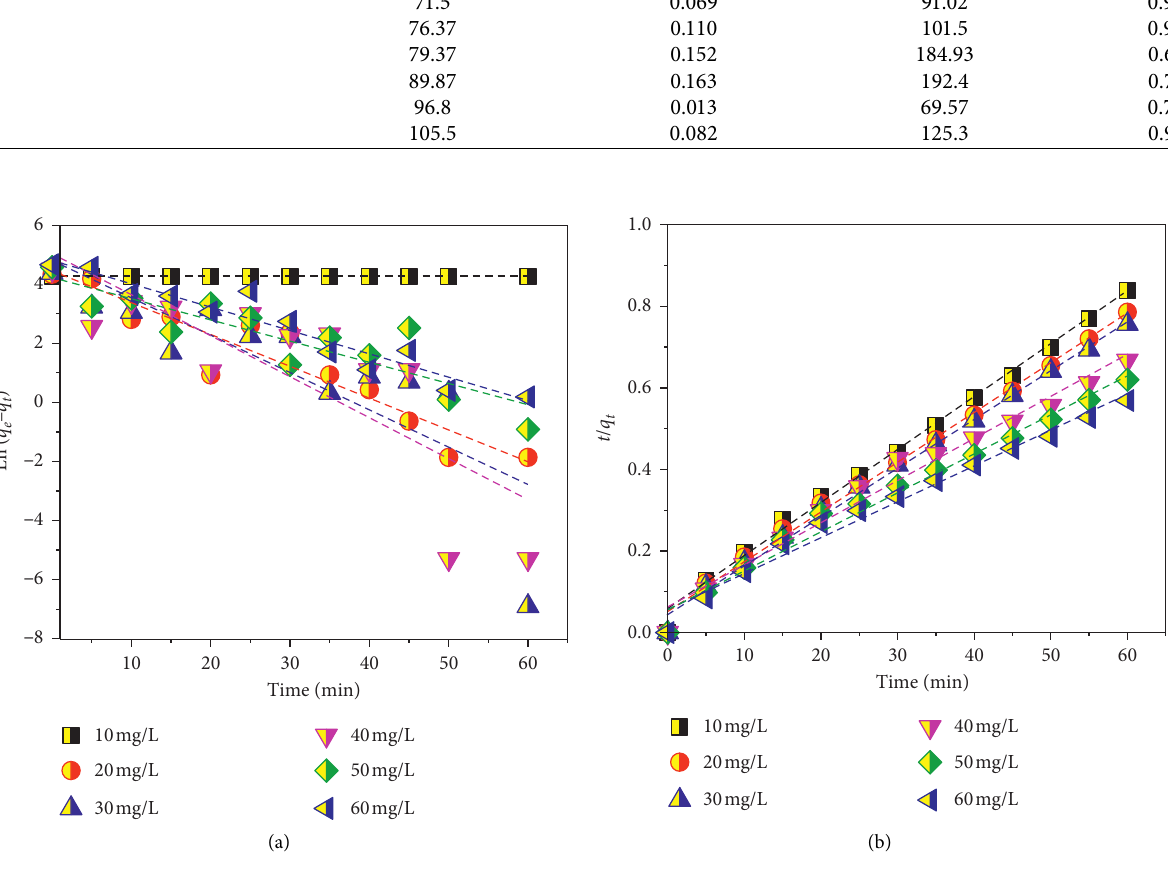
Figure 13: Pseudo-first-order kinetic of the RBB adsorption on RDP (a) and pseudo-second-order kinetic of the RBB adsorption on RDP (b). Table 4: Kinetic constants of the second-first-order model.